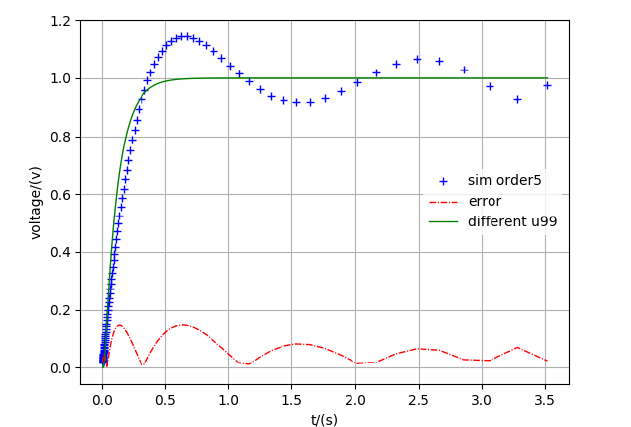
Figure 6. Simulation five-order.